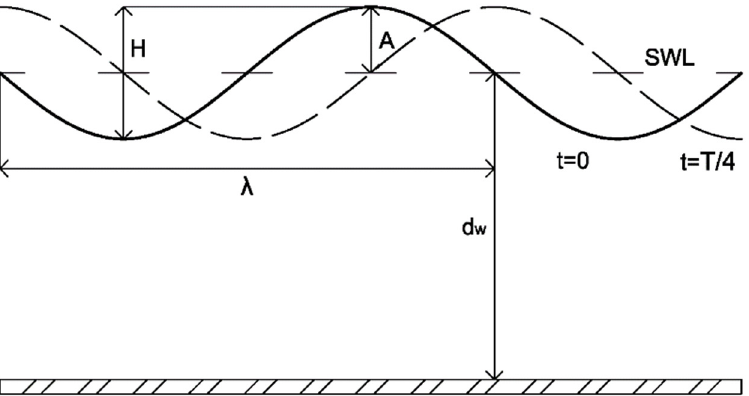
Figure 1. Parameters for a regular wave.